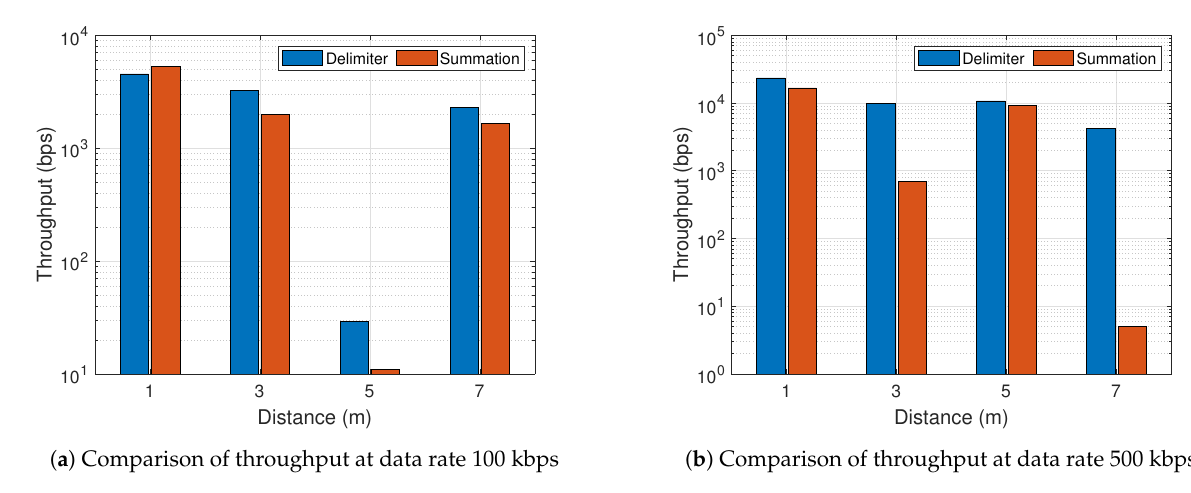
Figure 18. Results of throughput from the pattern-based decoding.